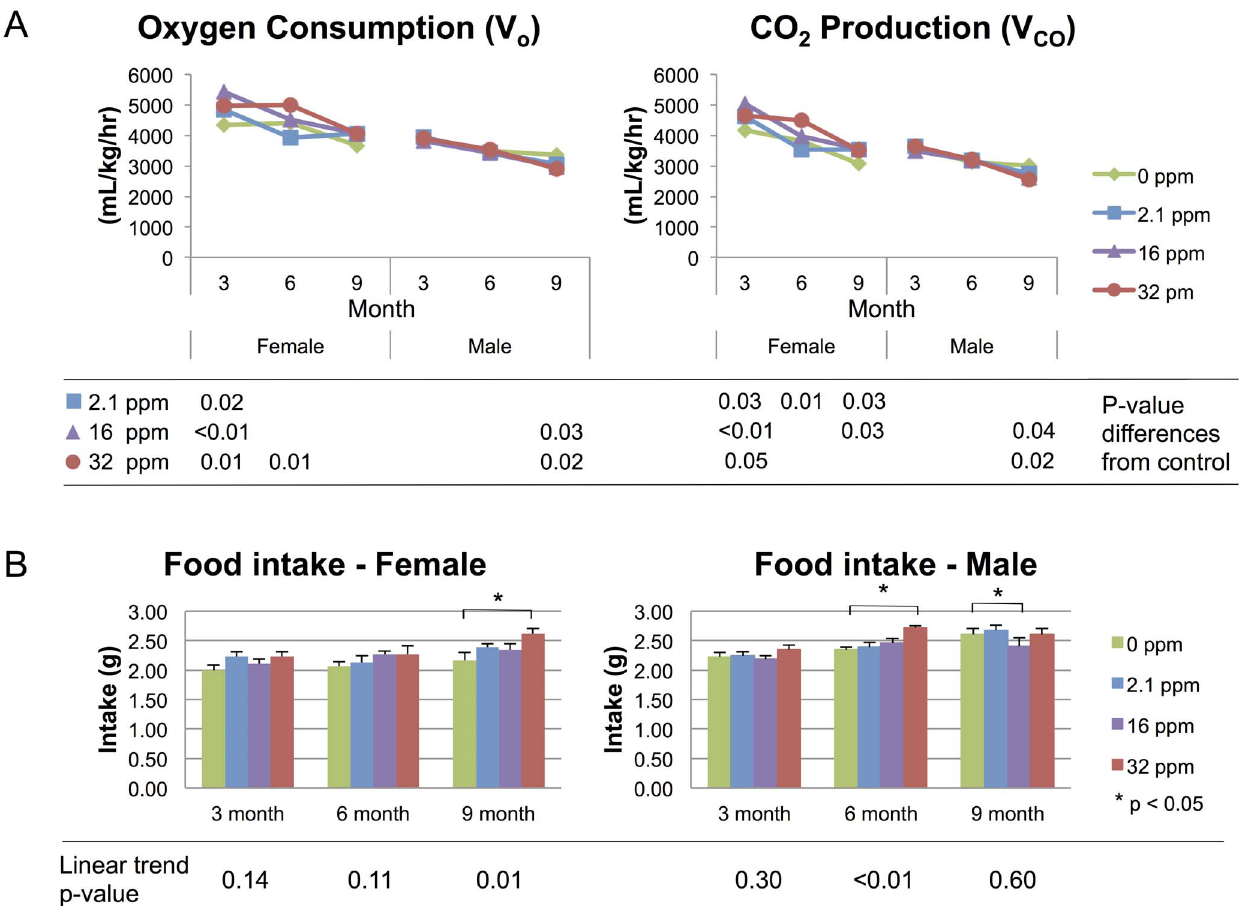
Figure 2. Energy Expenditure and Food Intake. Energy expenditure (mL/kg/hr) measured over a 72-hr period by indirect calorimetry. (A) Oxygen consumption and carbon dioxide (CO 2 ) production decline with age, across both sexes and all exposure groups. P-values represent differences from control. (B) Food intake across the life-course, stratified by sex. Stars indicate p-values , 0.05 as compared to control. Linear trend p- values represent exposure-dependent trend significance.